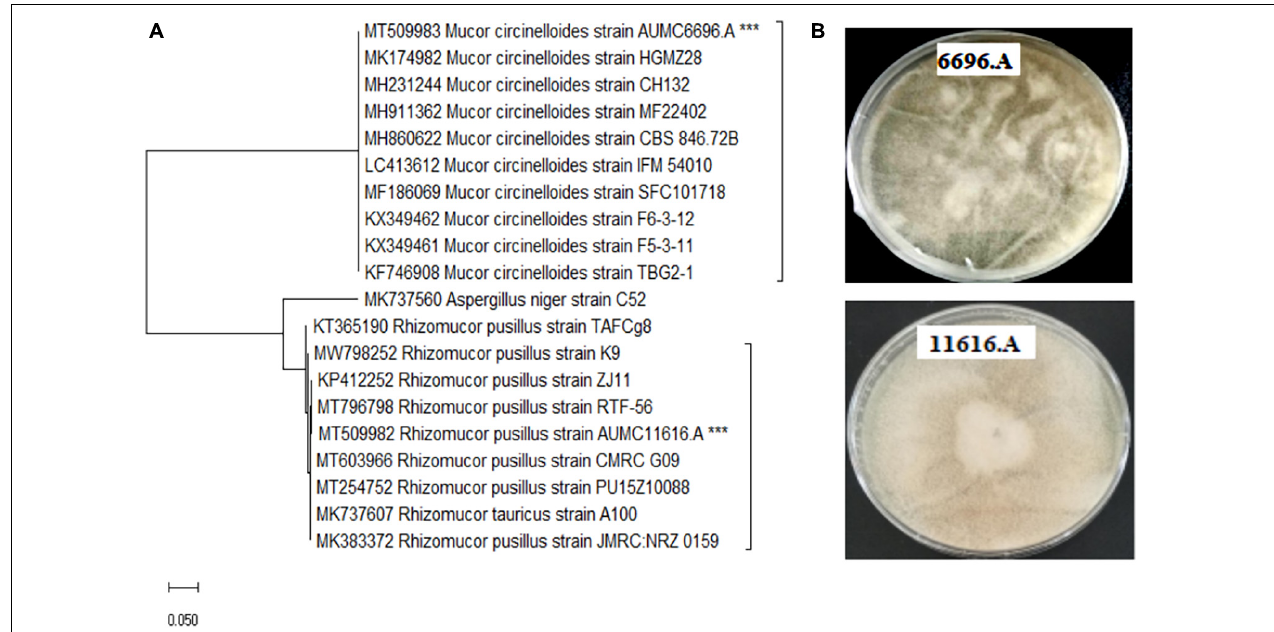
FIGURE 1 | (A) The neighbor-joining (NJ) phylogenetic tree based on ITS gene sequences of AUMC 6696.A and AUMC 11616.A, with closely related strains accessed from the GenBank using BLASTN (http://www.ncbi.nlm.nih.gov/blast/). These sequences were aligned using ClustalW. Bootstrap values included 500 replicates for the NJ method using MEGA software (version 11.0.6). ***indicates tested strain. (B) Morphological characteristics of tested strains on agar plates.